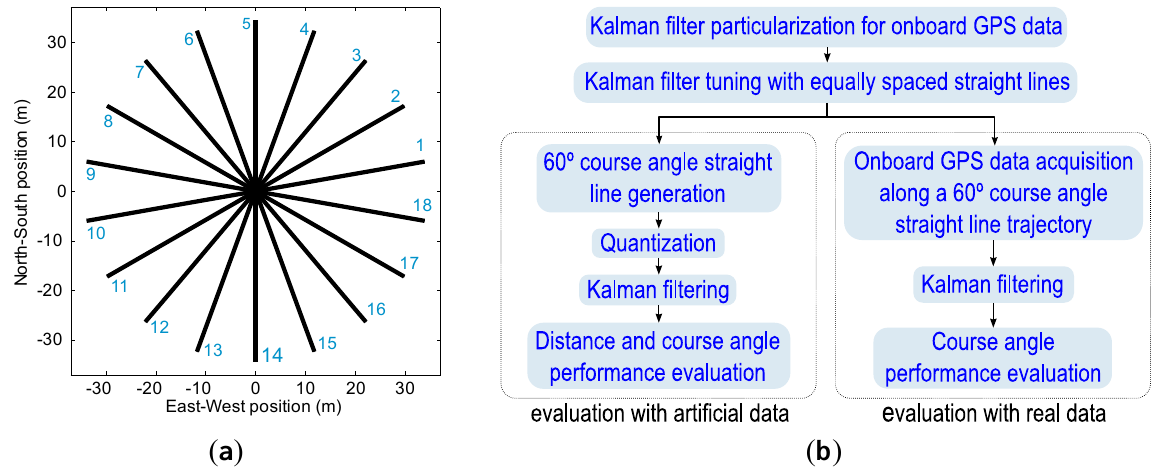
Figure 7. ( a ) Paths used in the tuning process and distance performance evaluation; ( b ) Flow charts of Kalman filter evaluation with artificial data and with onboard GPS real data.